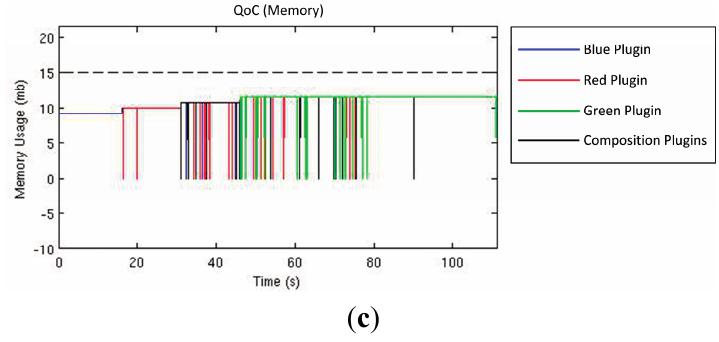
Figure 11. QoS and QoC values along tests performed: deadline ( a ); CPU load ( b ); and memory usage ( c